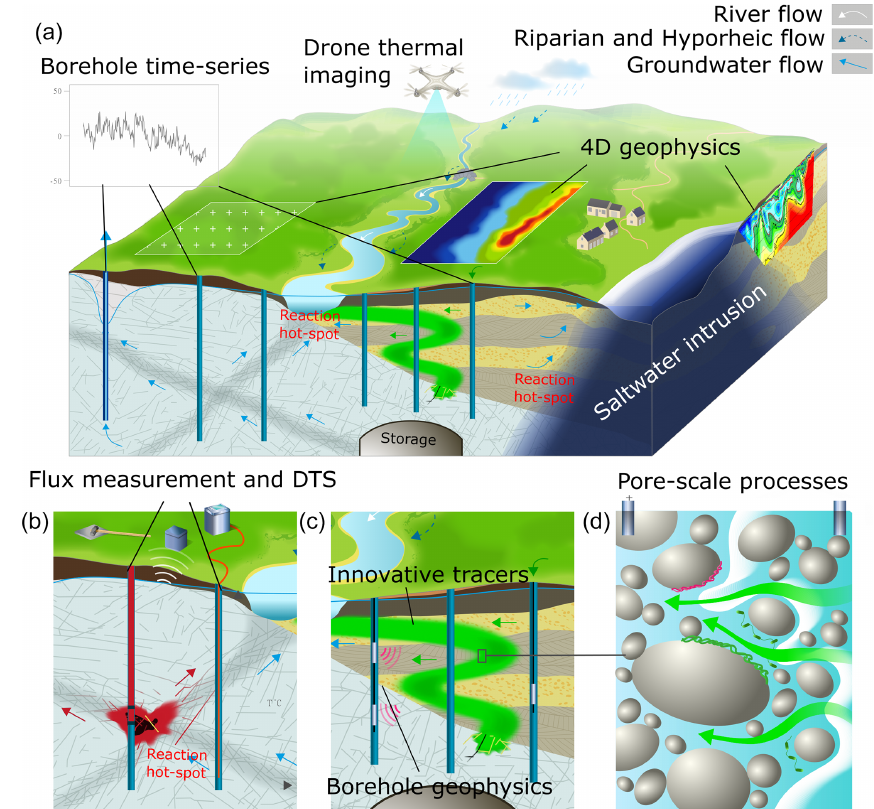
Figure 1. Illustration of the 4D nature of hydrogeological processes inaccessible from punctual data only: (a) imaging subsurface fluxes and their contribution to surface fluxes through the combination of borehole and surface imaging; (b) monitoring water content and temperature fluctuations for quantifying preferential flows and heat transfer; (c) characterizing tracer motion to elucidate transport processes and related parameters; and (d) analyzing and upscaling pore-scale signals produced by microscale reactive transport